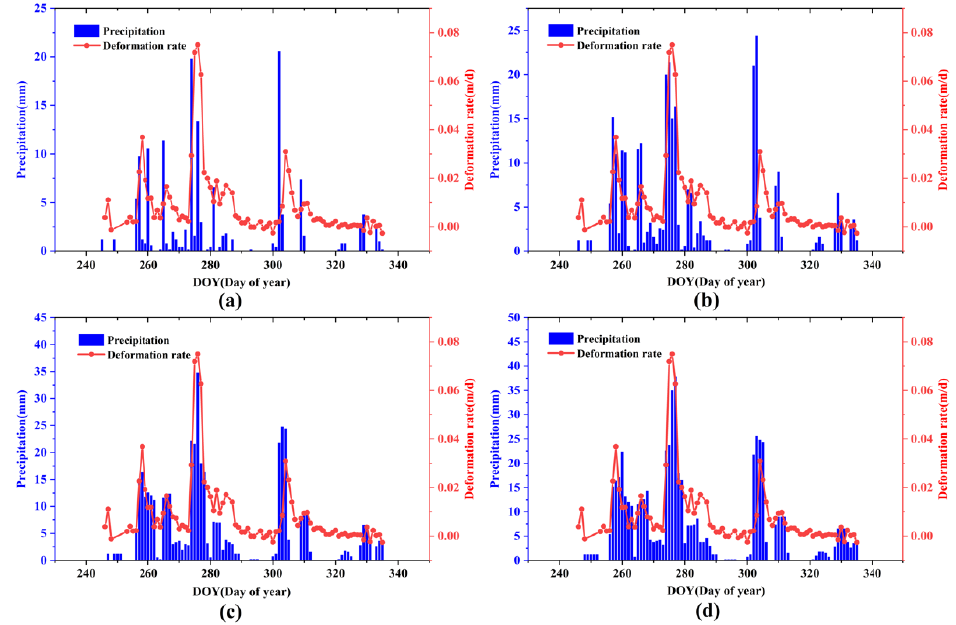
Figure 15. Relationship between deformation rate and ( a ) single-day rainfall; ( b ) two-day cumulative rainfall; ( c ) three-day cumulative rainfall; and ( d ) four-day cumulative rainfall.